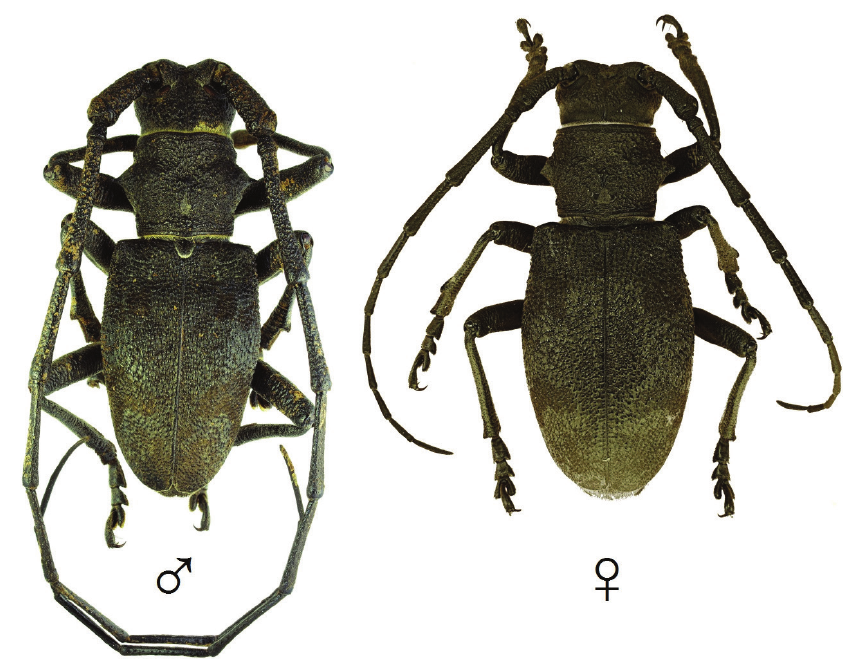
Figure 4. Sexual dimorphism in Morimus asper asper (photo by Federico Romiti).